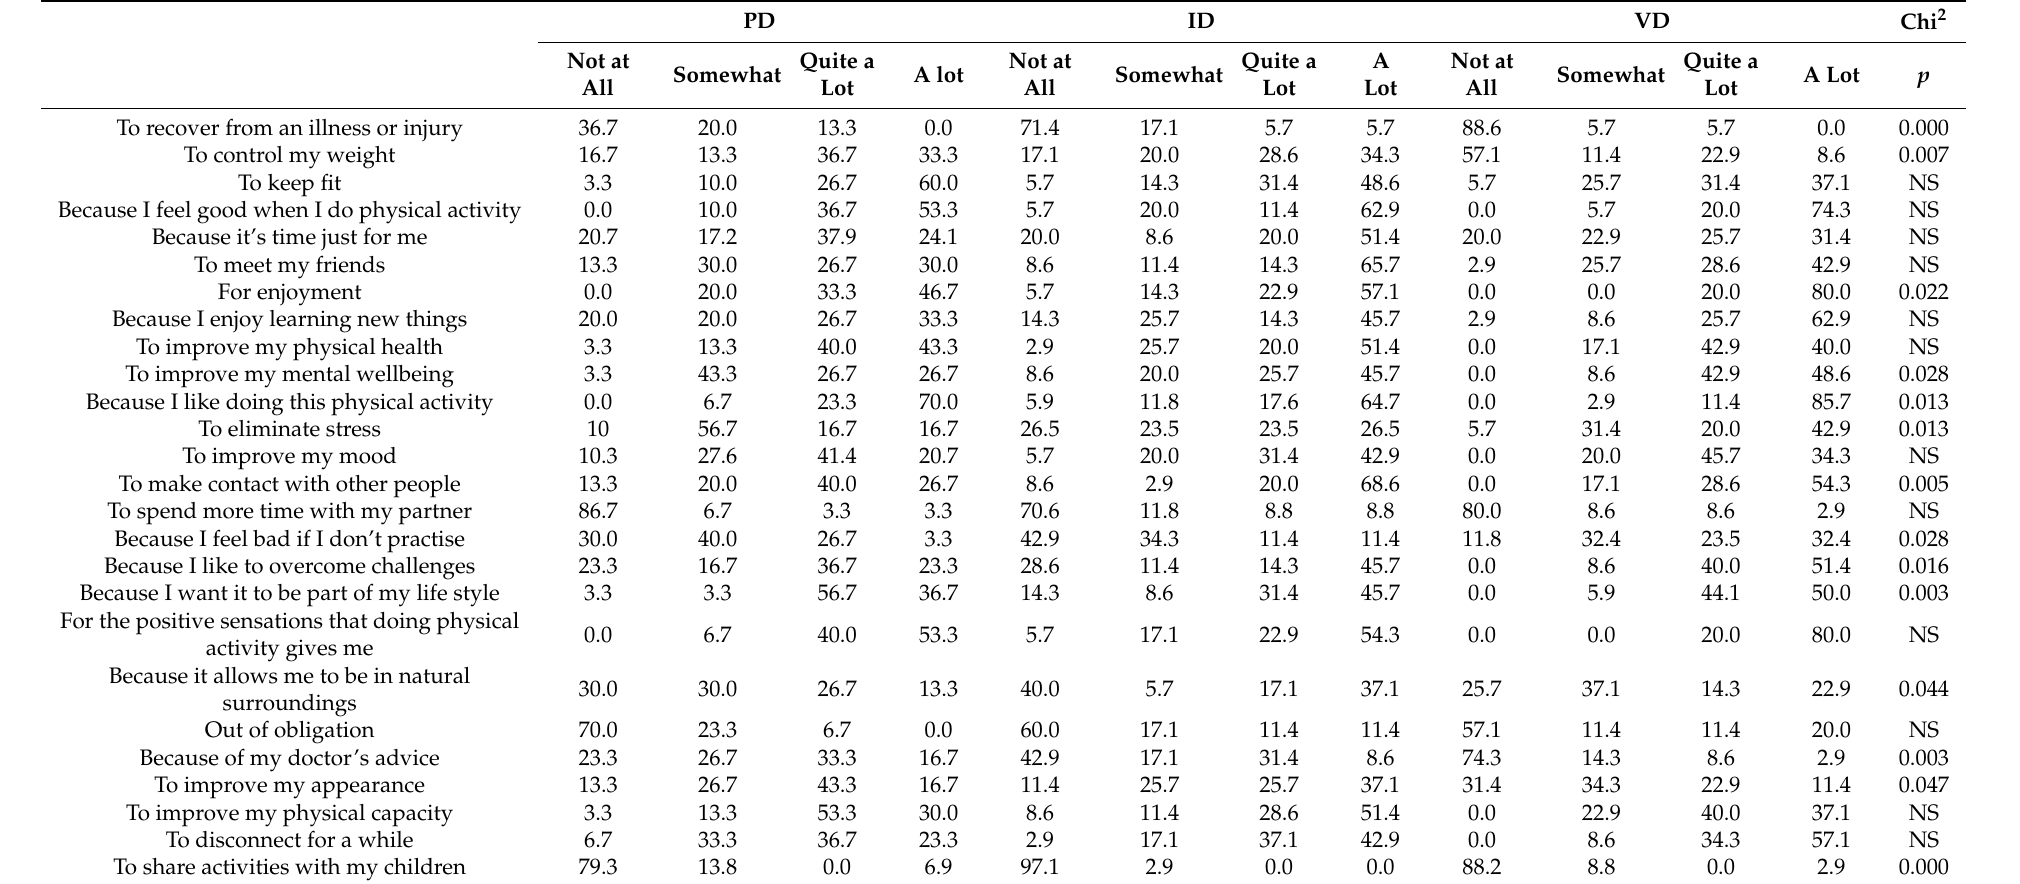
Table 6. Results (%) referring to the differences in the perceived motives for practising PA and sport according to type of